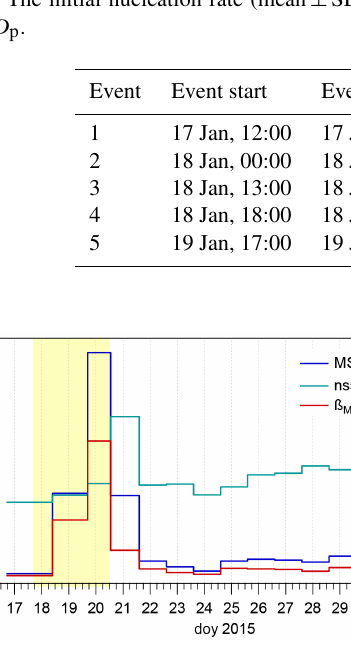
Figure 9. Time series of the measured MS − and nss–SO 2 − trations as well as the MS − / nss–SO 2 − aerosol (low volume) sampling during the campaign 2015. The pe- riod of LPS15 is shaded in